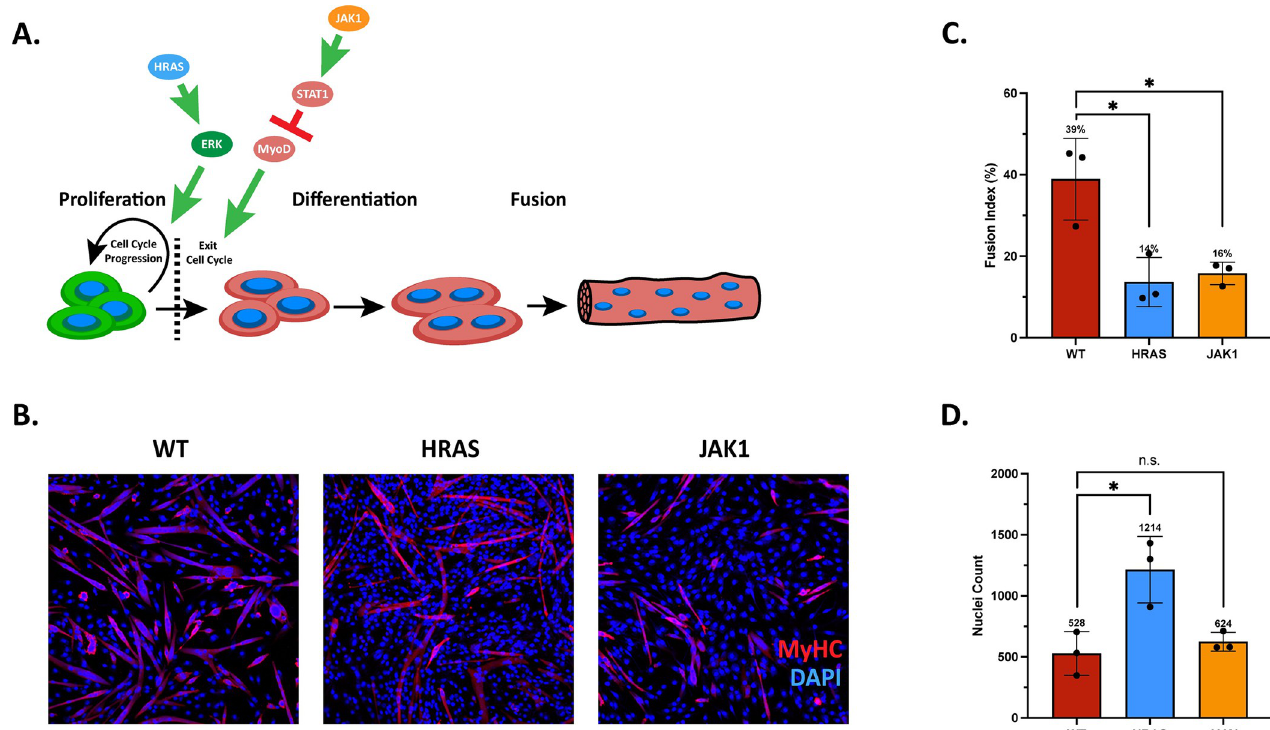
Fig 3. Anti-differentiation signals enable a myogenic regulatory system. A. Diagram of myoblast proliferation and differentiation. Myoblasts in a proliferative state will exit the cell cycle in response to low-serum medium. Myoblasts committed to differentiation express Myogenin before fusing together to form multinucleated myotubes that express MyHC. HRAS promotes proliferation via the MAPK/ERK pathway, causing continued cell growth. JAK1 promotes STAT1 expression, which inhibits MyoD, a key mediator of muscle differentiation. B. Representative immunofluorescence microscopy images of wild type (WT) and HRAS- and JAK1-overexpressed C2C12 cells. MyHC expression is shown in red while DAPI, a dye that stains DNA, is shown in blue. C. Quantification of fusion index from WT and HRAS- and JAK1-overexpressed C2C12 cells. D. Quantification of total nuclei from WT and HRAS- and JAK1-overexpressed C2C12 cells. Values are means; error bars indicate standard deviation of three biological replicates; asterisks indicate significance based on p-values from t-test, n.s. indicates not significant, � p < 0.01, �� p < 0.001, ��� p < 0.0001, ���� p < 0.00001.